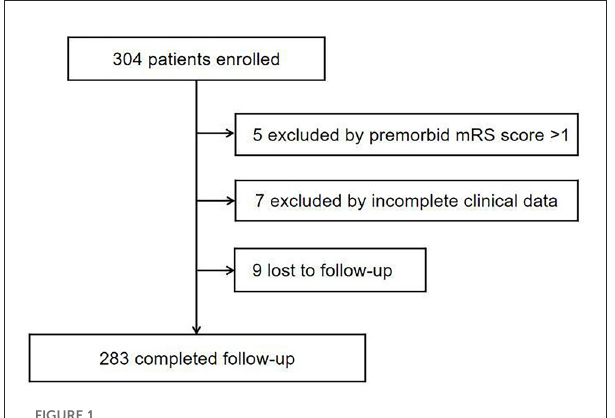
FIGURE1 The flowchart of the study.